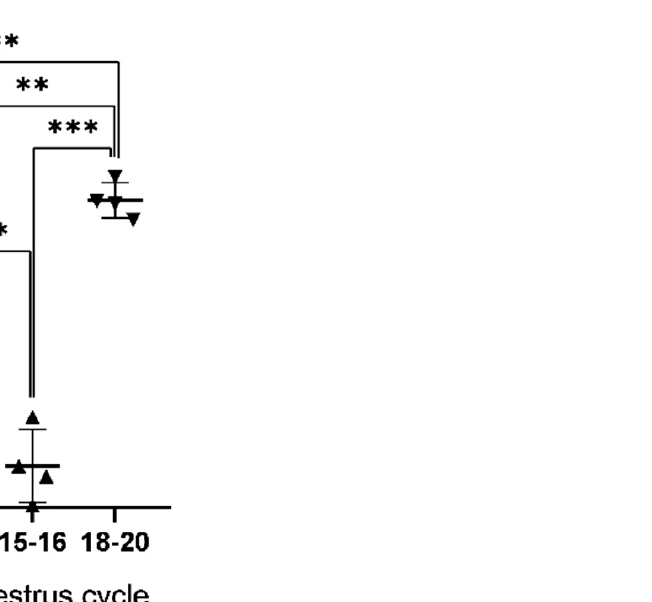
Figure 2. Relative mRNA transcript abundance of CYP27B1 and CYP24A1 in the endometrium ( a , b , respectively) and CYP27B1 in the myometrium ( c ) obtained from pigs on days 2–5, 10–12, 15–16 and 18–20 of the estrous cycle. Relative mRNA transcript abundance (quantitative real–time PCR) was expressed as the ratio relative to GAPDH (glyceraldehyde–3–phosphate dehydrogenase) and was presented as 2 −Δ Ct . Each value represents the mean ± SD. * p < 0.05; ** p < 0.01; *** p < 0.001 (one–way ANOVA followed by Tukey post hoc test). n = 5 per each group. 2.3. Abundance of CYP27B1 and CYP24A1 Proteins in the Porcine Uterus The abundance of CYP27B1 and CYP24A1 proteins in the porcine endometrial and myometrial slices was examined on days 2–5, 10–12, 15–16 and 18–20 of the estrous cycle